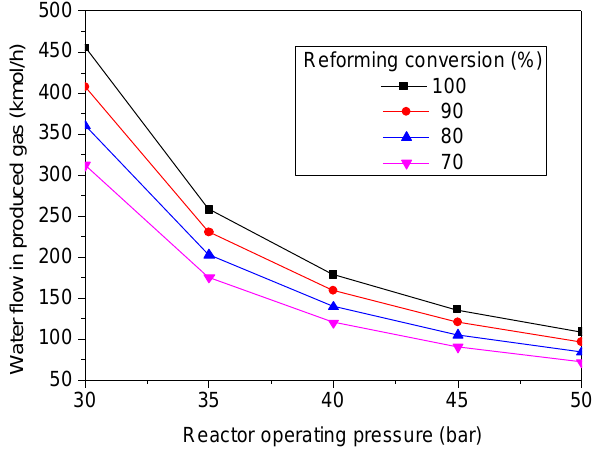
Figure 6. Molar flow of water evaporated in APR reactor vs. operating pressure.